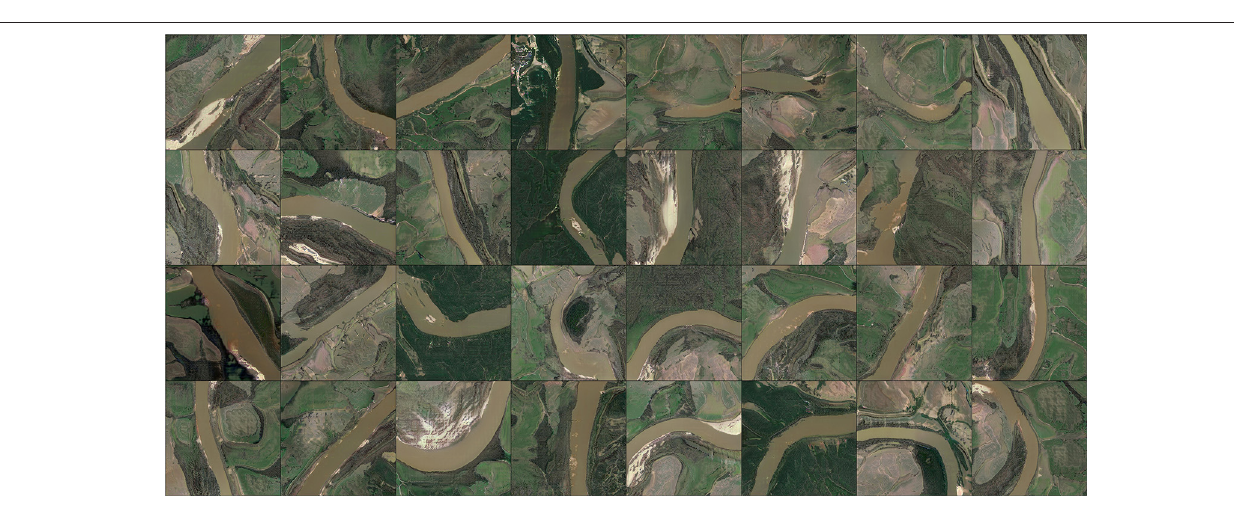
FIGURE 6 | Set of 32 PGGAN-generated satellite river imagery at 1,024 × 1,024